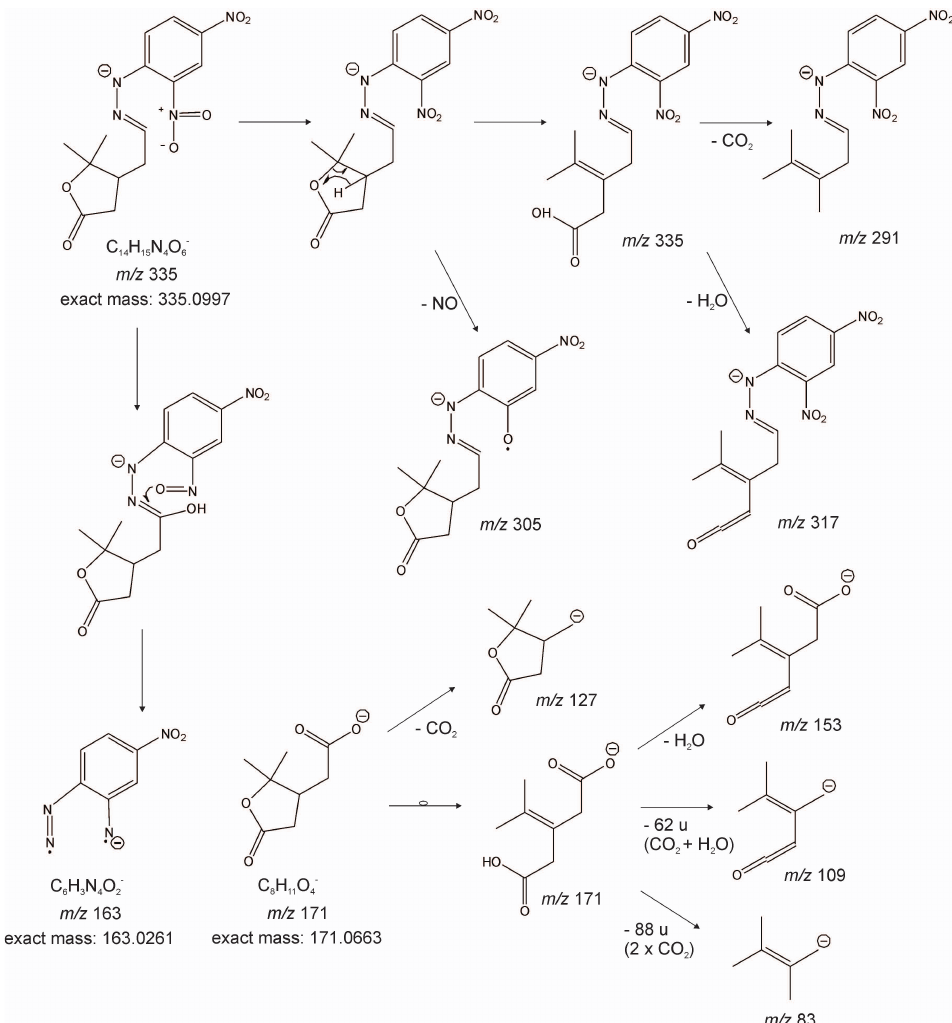
Fig. 7. Proposed fragmentation mechanism for the m / z 335 compound showing MS 2 and MS 3 ( m / z 335 → m / z 171) product ions.